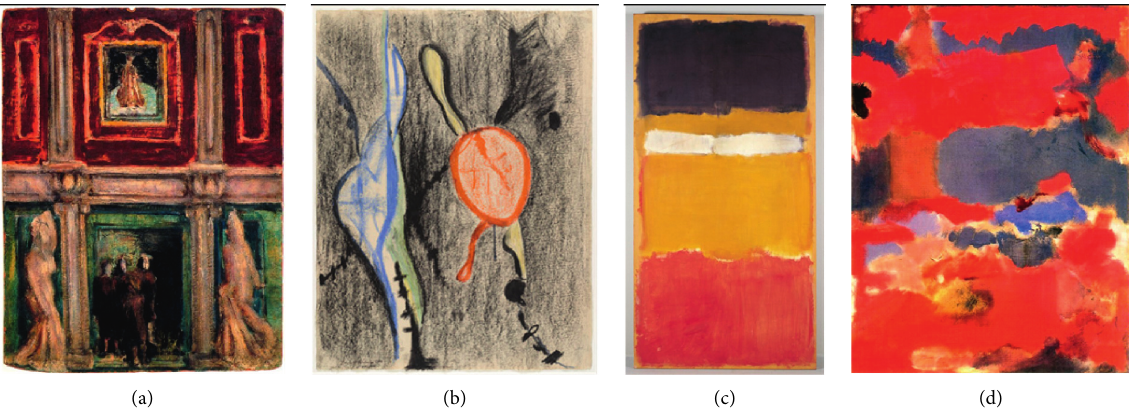
Figure 21: Multiplex MultiRank top 4 paintings in the dataset between 1934 and 1952. (a) Mark Rothko: Interior , 1936 (Surrealism). (b) Barnett Newman: The Blessing , 1944 (Abstract Expressionism). (c) Mark Rothko: Number 24 (Untitled) , 1951 (Color Field Painting). (d) Mark Rothko: Untitled , 1948 (Color Field